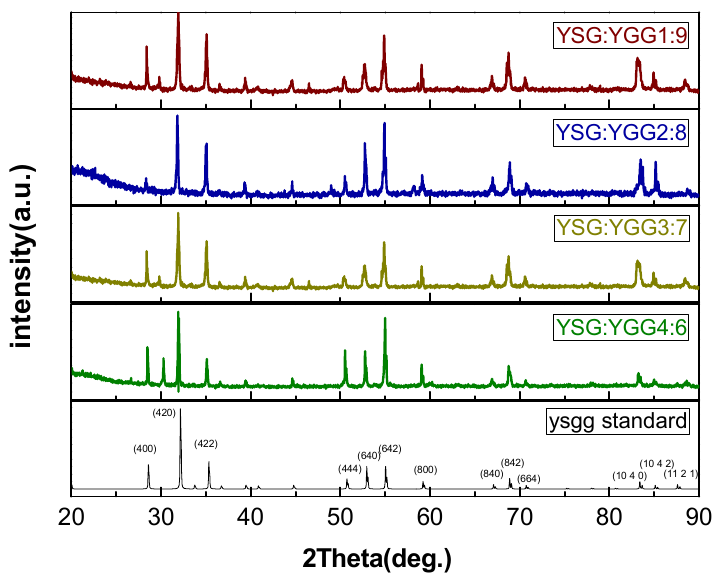
Figure 10. The XRD patterns of the samples of YSG:YGG 1:9, 2:8, 3:7, 4:6 and YSGG standard for comparison.